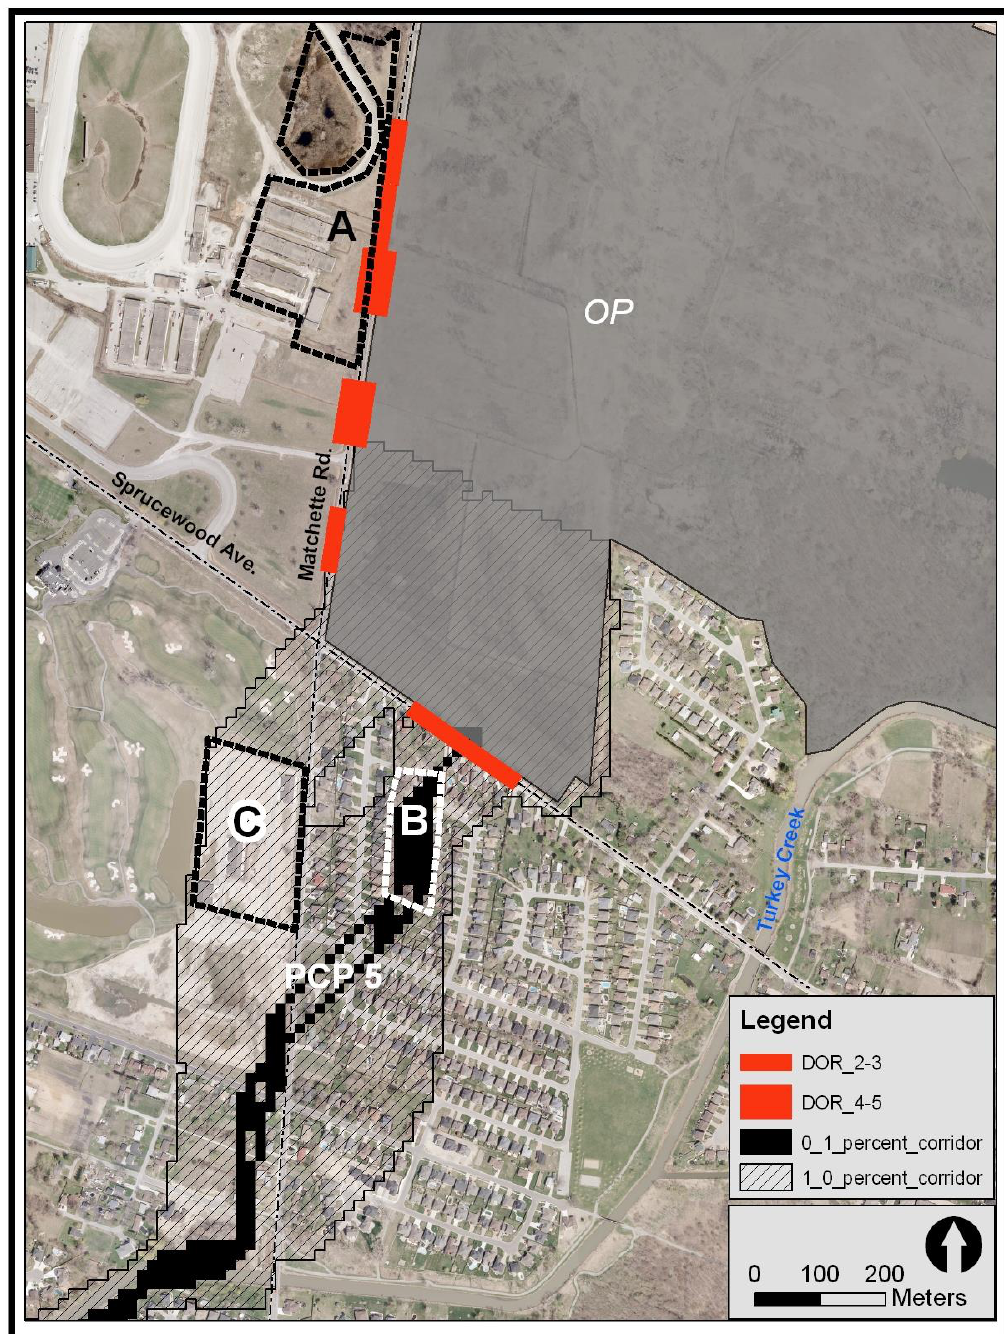
Figure 12. A possible explanation for the inaccuracy of PCP5. Polygon A indicates a parcel of naturalized meadow (naturalized open area) that was classified as urban pervious. Polygon B indicates a remnant parcel of forest that has been converted to residential land use (urban impervious). Polygon C indicates a portion of a golf course that has been converted to residential land use.